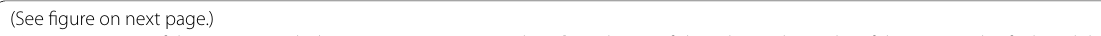
figure on next Fig. 5 Dynamics of the Japan Trench during a seismic super-cycle. a , b Evolution of slip velocity down-dip of the mega-splay fault and the megathrust, respectively, for 1000 years. The horizontal dashed profiles indicate segment boundaries. The stars indicate the hypocenters of earthquake nucleation, colored by the peak slip velocity attained during the event. Partial ruptures are confined to the forearc basement. During giant ruptures, slip propagates to the trench and to the mega-splay fault. Afterslip follows all ruptures. The cluster of events before and after giant ruptures corresponds to foreshocks and aftershocks, respectively. c Evolution of slip velocity at the center of each velocity-weakening segment and peak velocity anywhere along the megathrust/mega-splay system. The recurrence time of ruptures in the mantle-wedge corner increases during a super-cycle. d Peak strain rate in the oceanic asthenosphere and in the mantle wedge. e Sequence of full and partial ruptures, foreshocks and aftershocks, and style of rupture. Each event is indicated by a star colored by the peak slip velocity attained during rupture